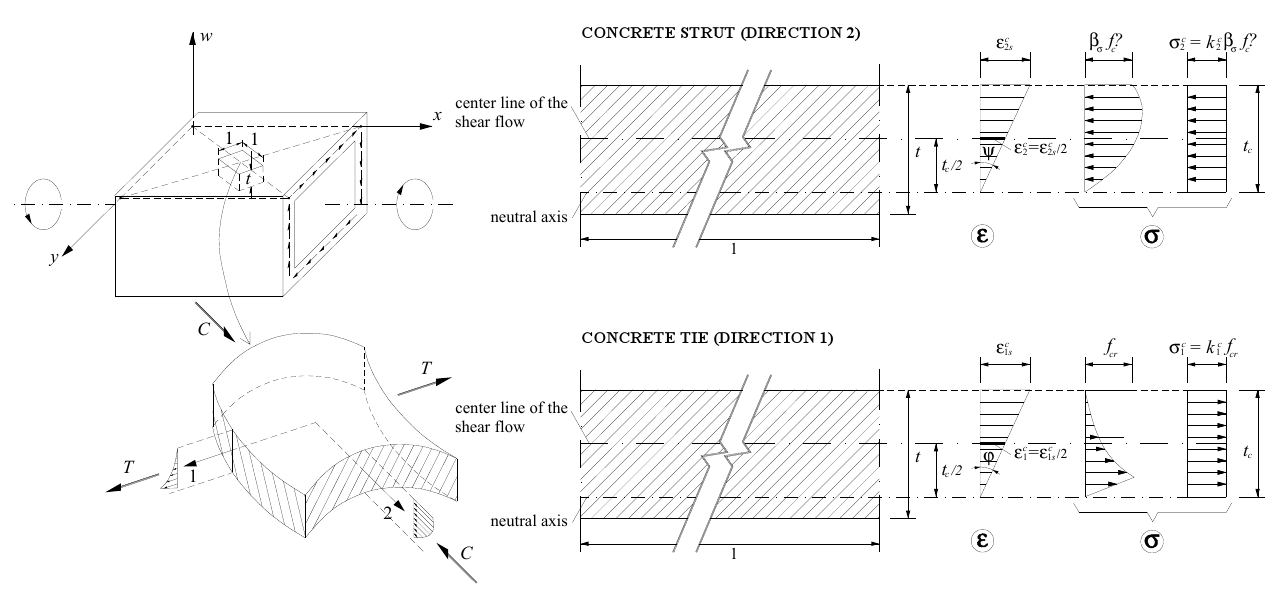
Figure 3. Curvatures and strain gradient in the walls [18].